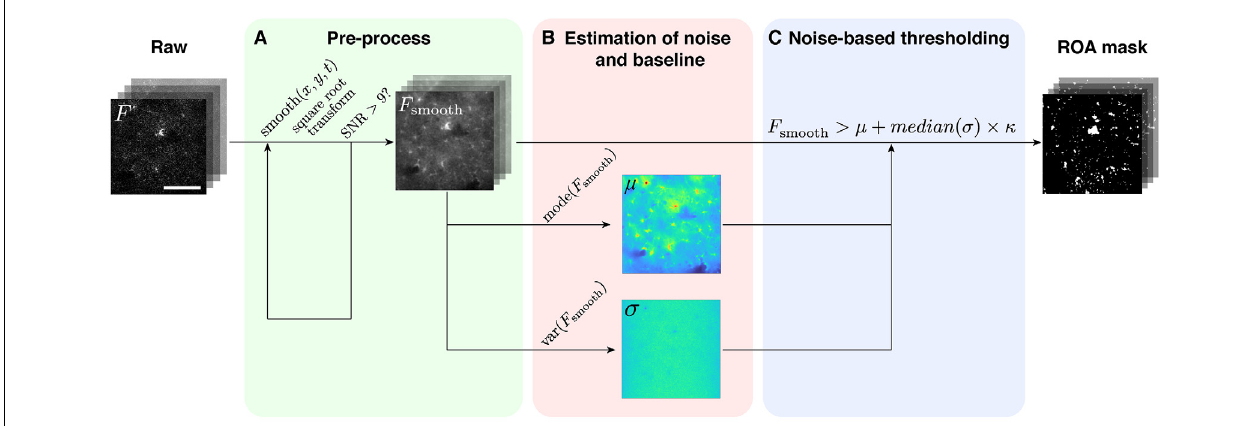
FIGURE 2 | The ROA algorithm. (A) The raw data ( F ) are spatiotemporally smoothed and transformed ( F smooth ) until an acceptable SNR is attained. (B) In each pixel, the baseline value ( µ ) and the standard deviation ( σ ) of the root gray values are then estimated from F smooth (temporal smoothing applied by merging frames). (C) F smooth is then binarized by applying a threshold defined as the baseline value ( µ ) plus κ times the standard deviation of the noise ( σ ; temporal smoothing applied with a moving